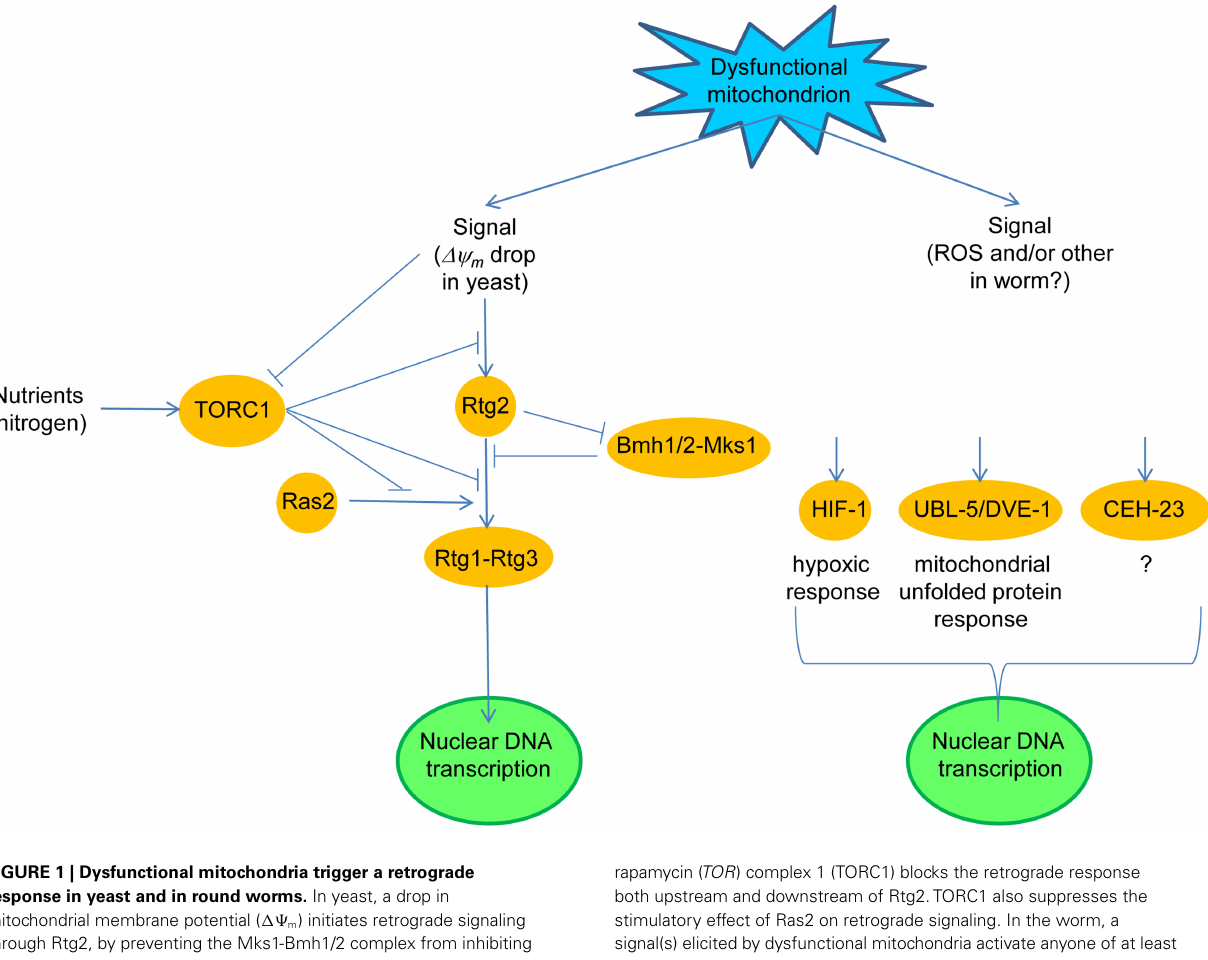
rapamycin ( TOR ) complex 1 (TORC1) blocks the retrograde response both upstream and downstream of Rtg2.TORC1 also suppresses the stimulatory effect of Ras2 on retrograde signaling. In the worm, a signal(s) elicited by dysfunctional mitochondria activate anyone of at least three retrograde signaling pathways defined by the transcription factor which is activated.The transcription factor can be HIF-1, activated by reactive oxygen species (ROS), UBL-5 and DEV-1, or the putative transcription factor